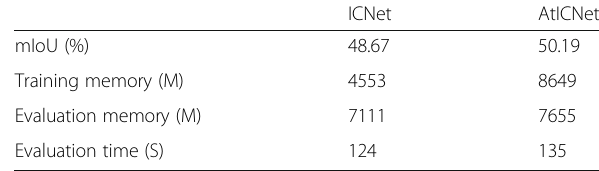
Table 3 The last training result AtICNet ’ s mIoU is higher than ICNet. The evaluation time is only 11 s longer than that of ICNet